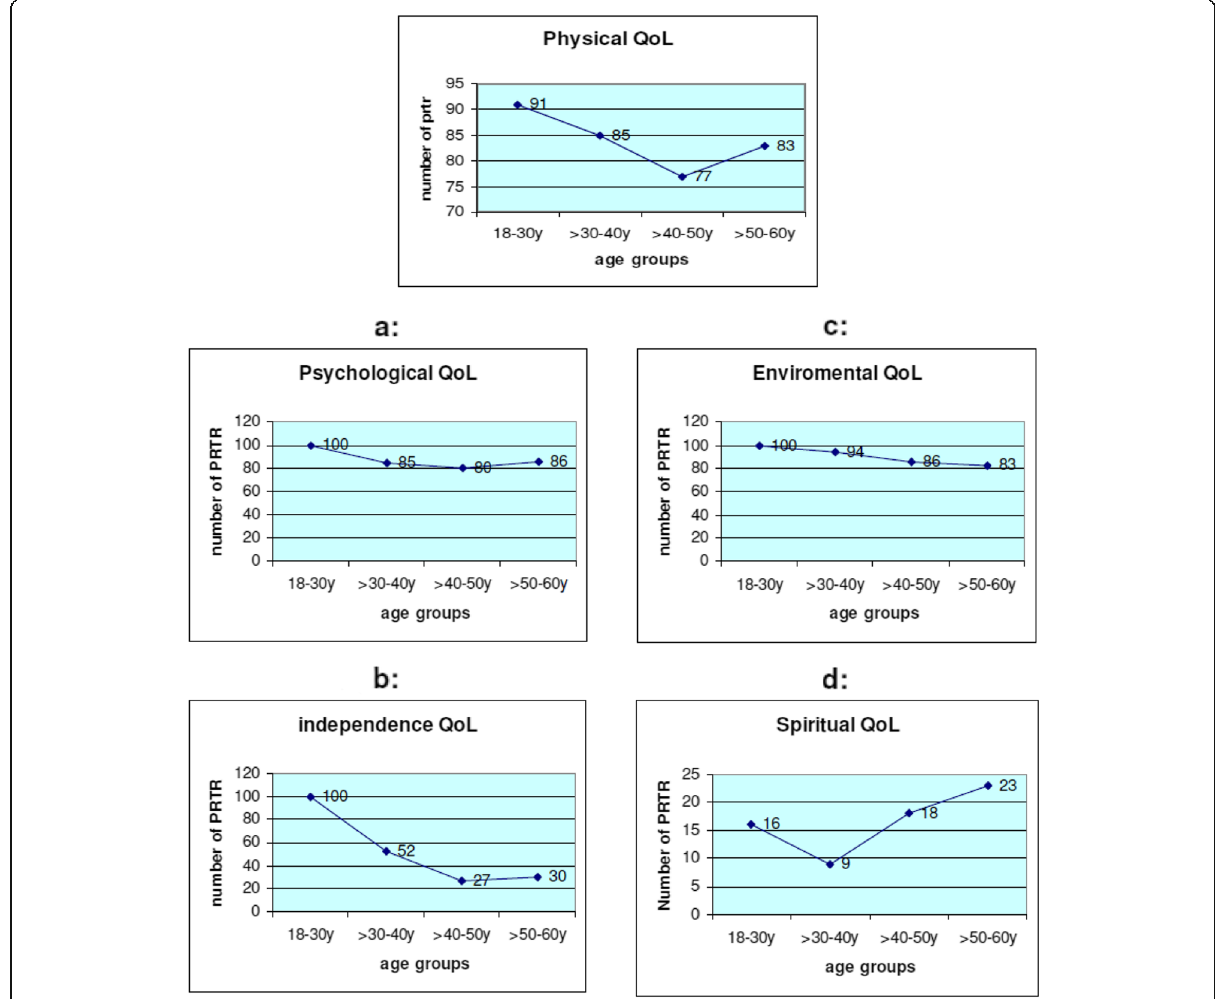
Fig. 2 Different domains of unsatisfactory quality of life in relation to age